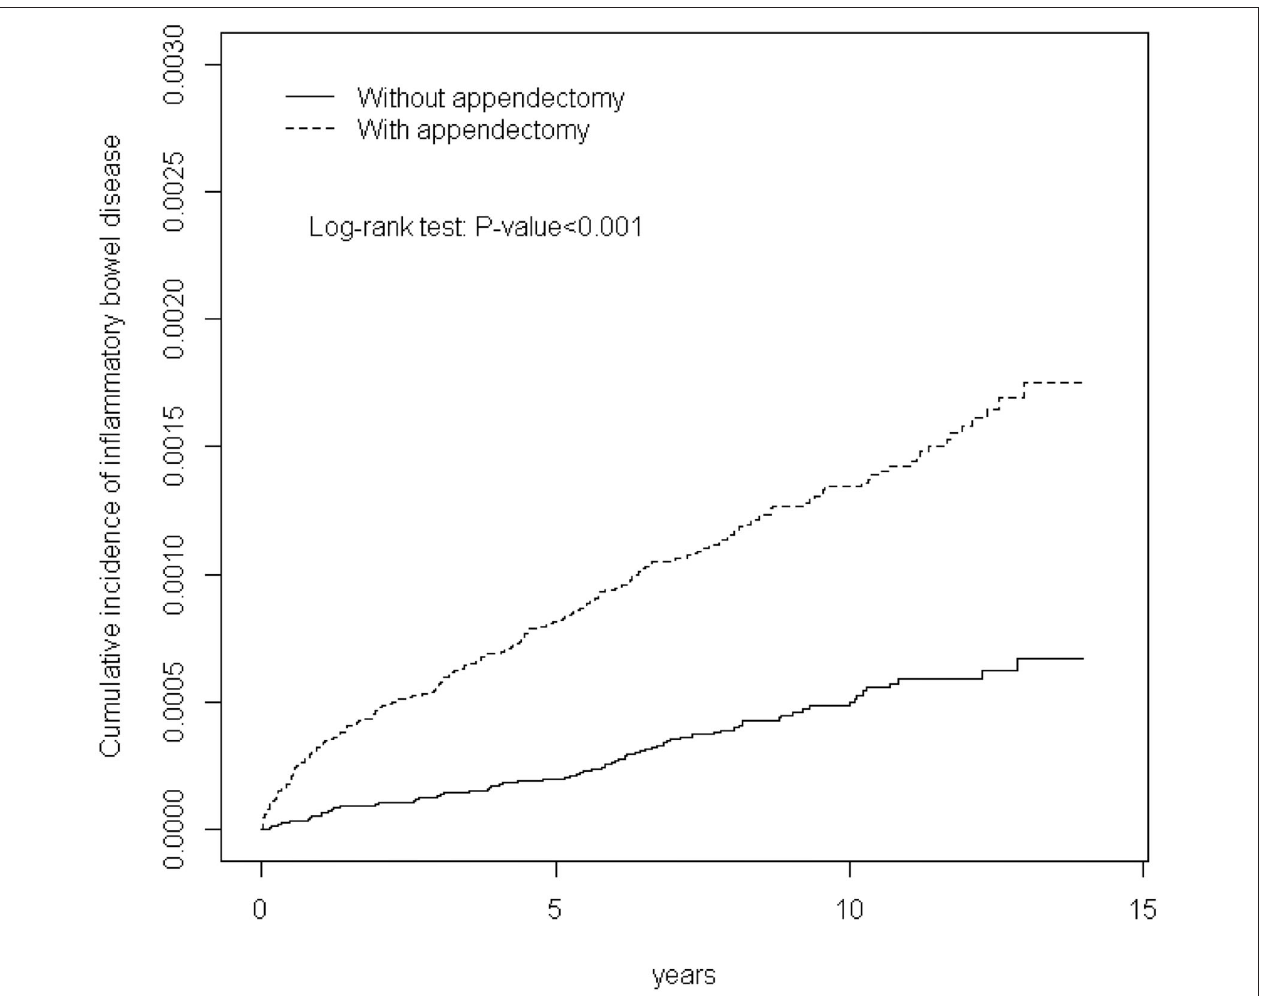
FIGURE 1 | Cummulative incidence of inflammatory bowel disease in patients with appendectomy and comparison